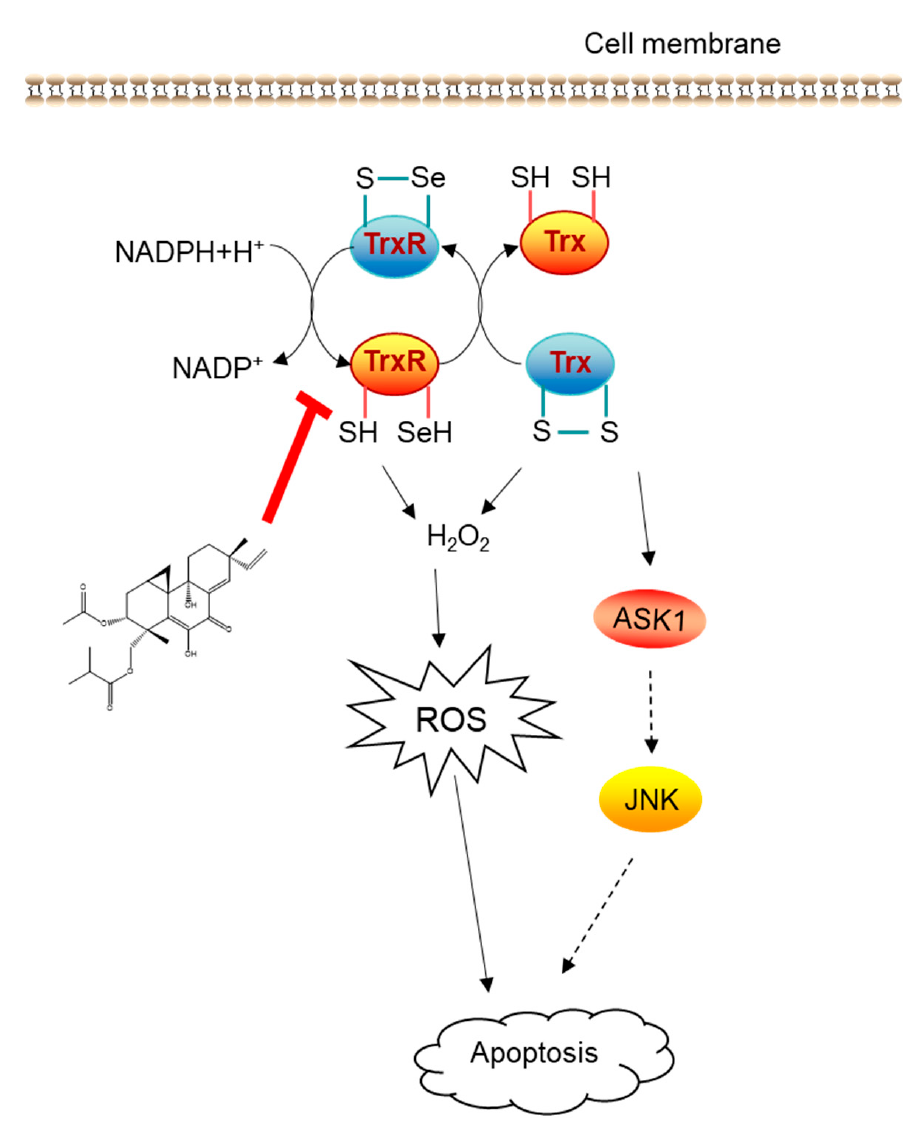
Figure 5. LH-mediated intracellular signaling pathway induced apoptosis in human pancreatic cancer cells.